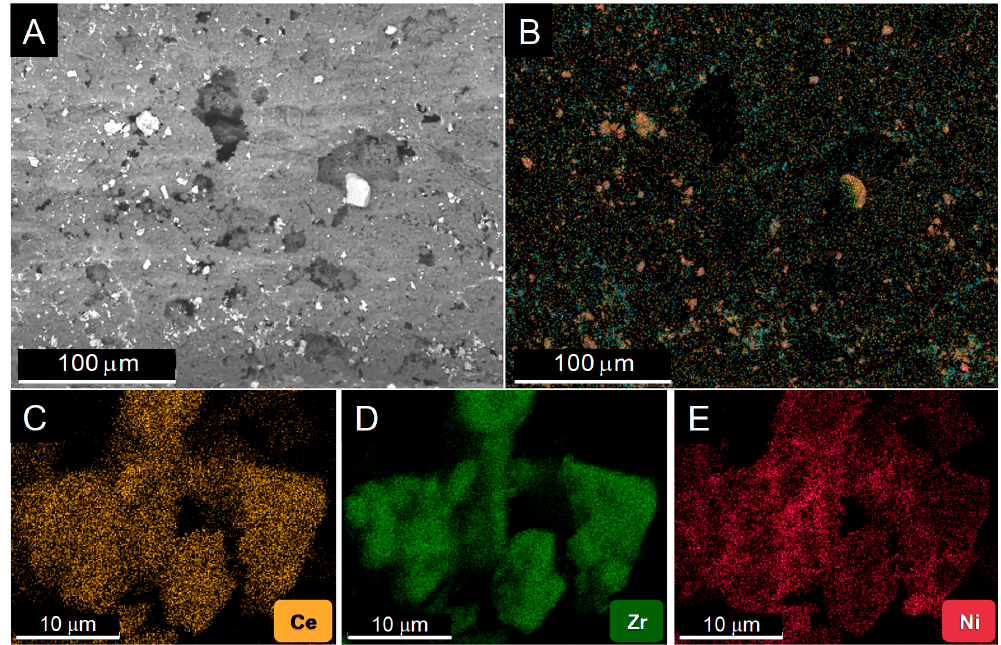
Figure 1. Representative secondary electron Scanning Electron Microscopy (SEM) image of the monolith inner walls ( A ) and the corresponding composed SEM-EDS map overlaying the chemical maps of the different elements in the active phase ( B ). Individual maps for Ce ( C ), Zr ( D ), and Ni ( E ) were obtained from a more reduced area of the sample.